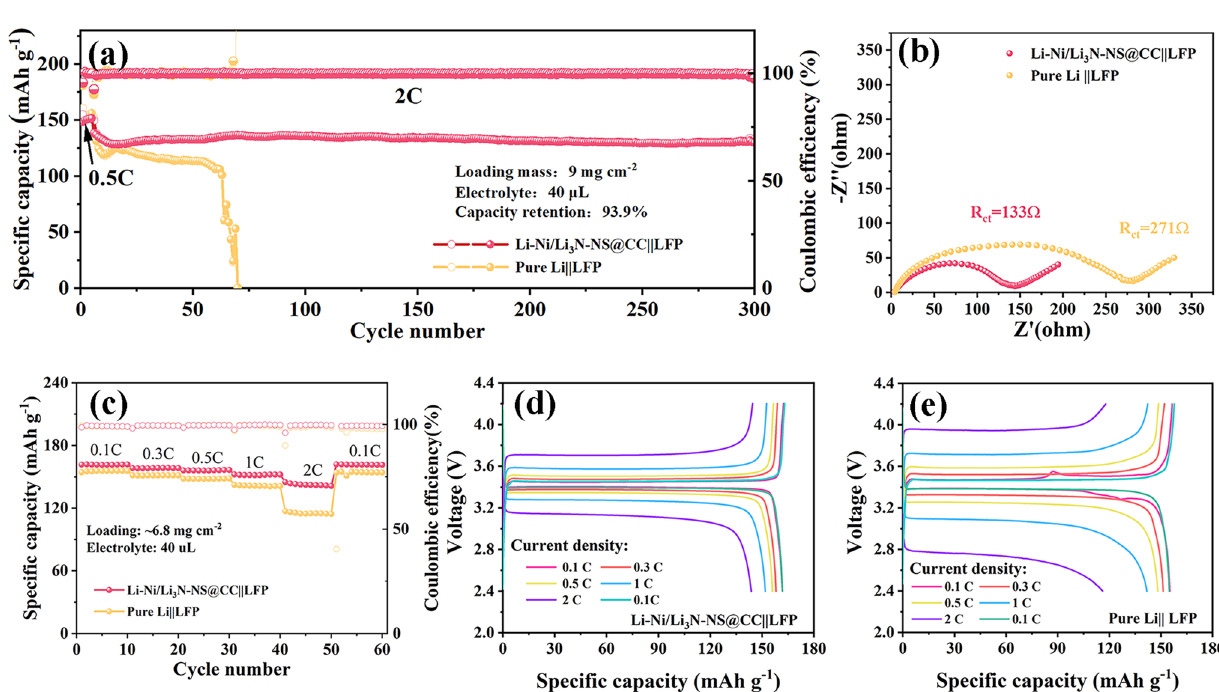
Fig. 6 a Cycling stability obtained at a current density of 2C with high loading mass of 9 mg cm −2 . b The Nyquist plots of full batteries with the Li-Ni/Li 3 N-NS@CC, and pure Li electrodes after cycling. c Rate performance measured from 0.1 to 2C. Galvanostatic charge–discharge profiles of d Li-Ni/Li 3 N-NS@CC||LFP and e pure Li||LFP full batteries obtained at different current